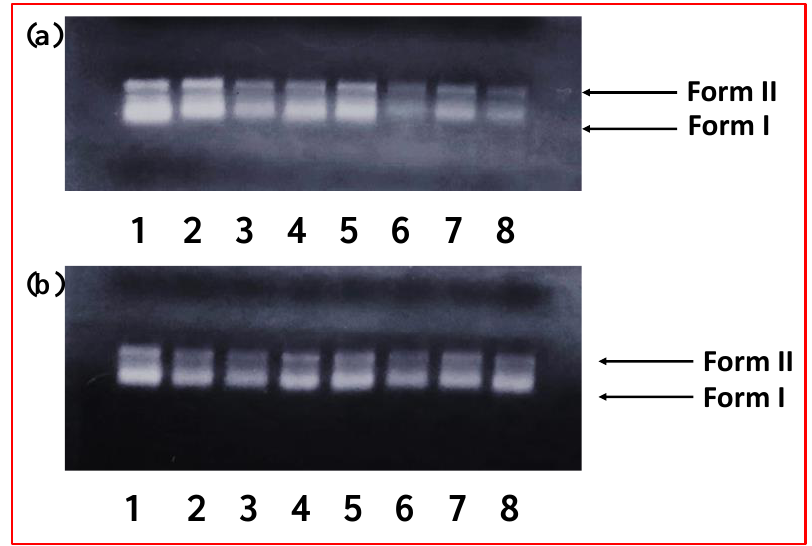
Figure 12. Plasmid DNA cleavage activity of ( a ) GO-NCD- 1 and ( b ) GO-NCD- 2 . Lane 1 = DNA control. Lane 2 – 8 (EtOH, DMSO, NaN 3 , SOD, MG, H 2 O 2 , and GSH).